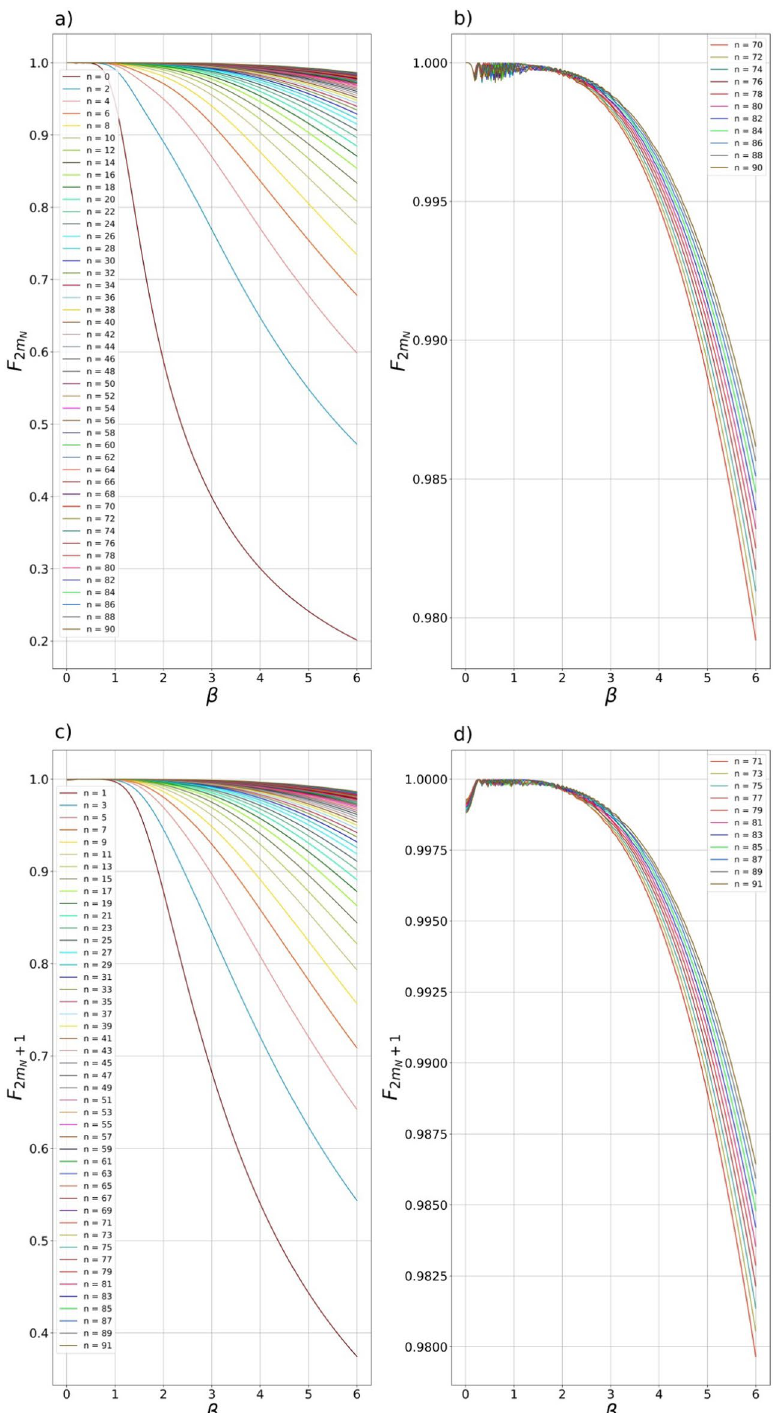
1 1 fidelities between 2 m , 2 m + − +